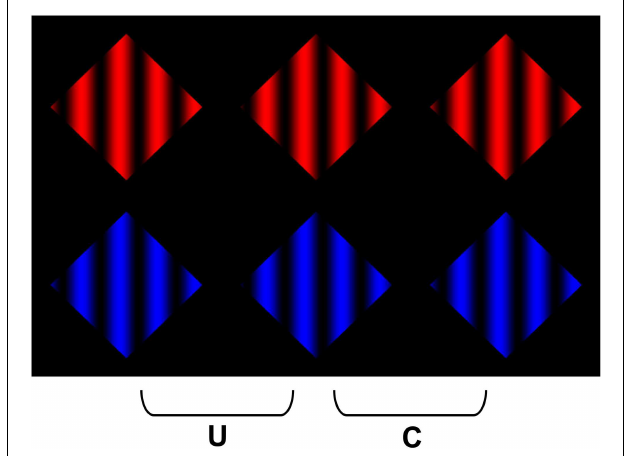
FIGURE 6 |The stimuli used in Experiment 2 to test for any systematic differences in the perceived depth of the red and blue components of the stereo images used in Experiment 1.